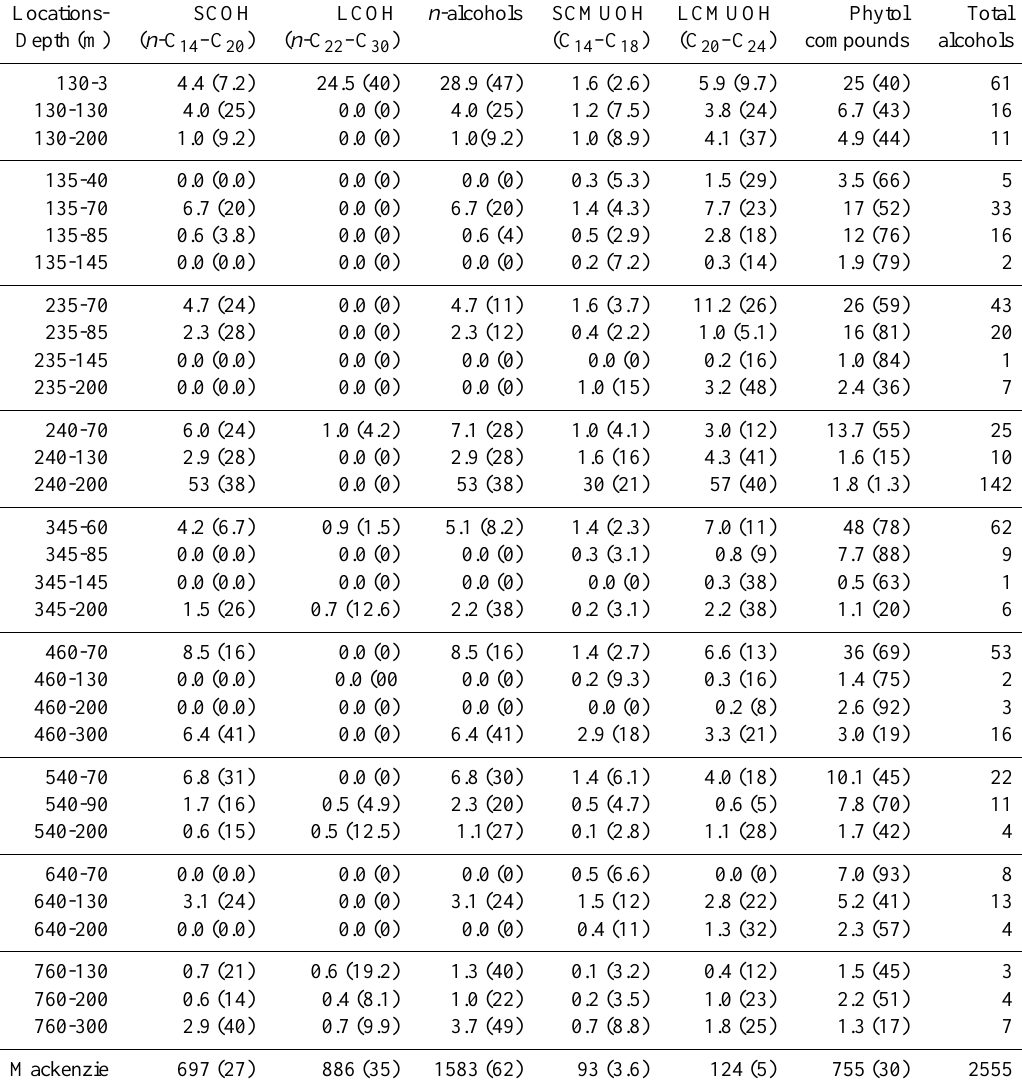
Table 5. Alcohol concentrations in the suspended particles from the Beaufort Sea (ngL − 1 ). Percentage of total alcohols is given in brackets. Locations- SCOH